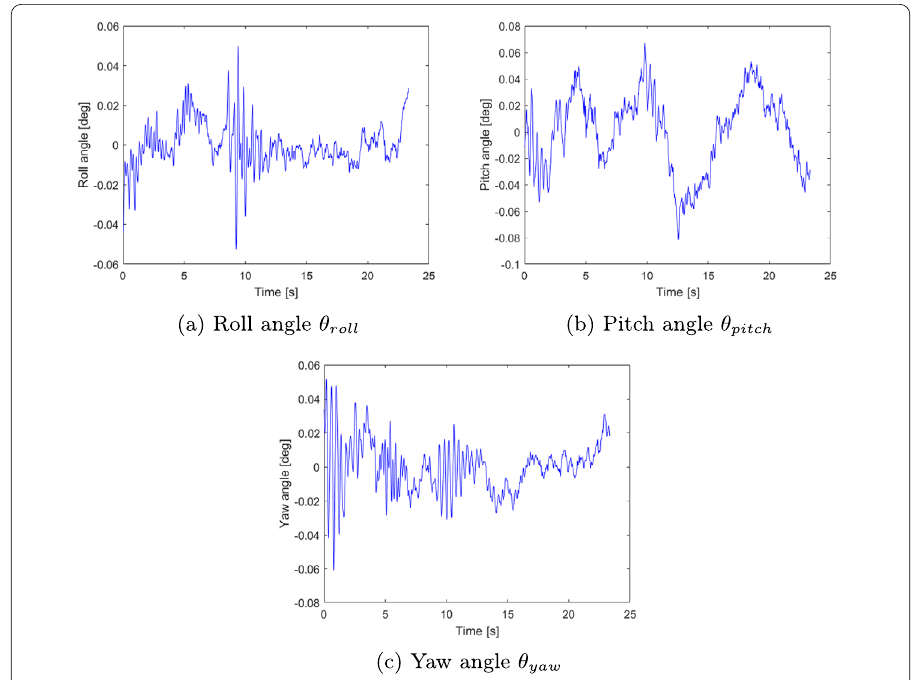
Figure 8 Raw angular movement data for roll, pitch and yaw axes of link L